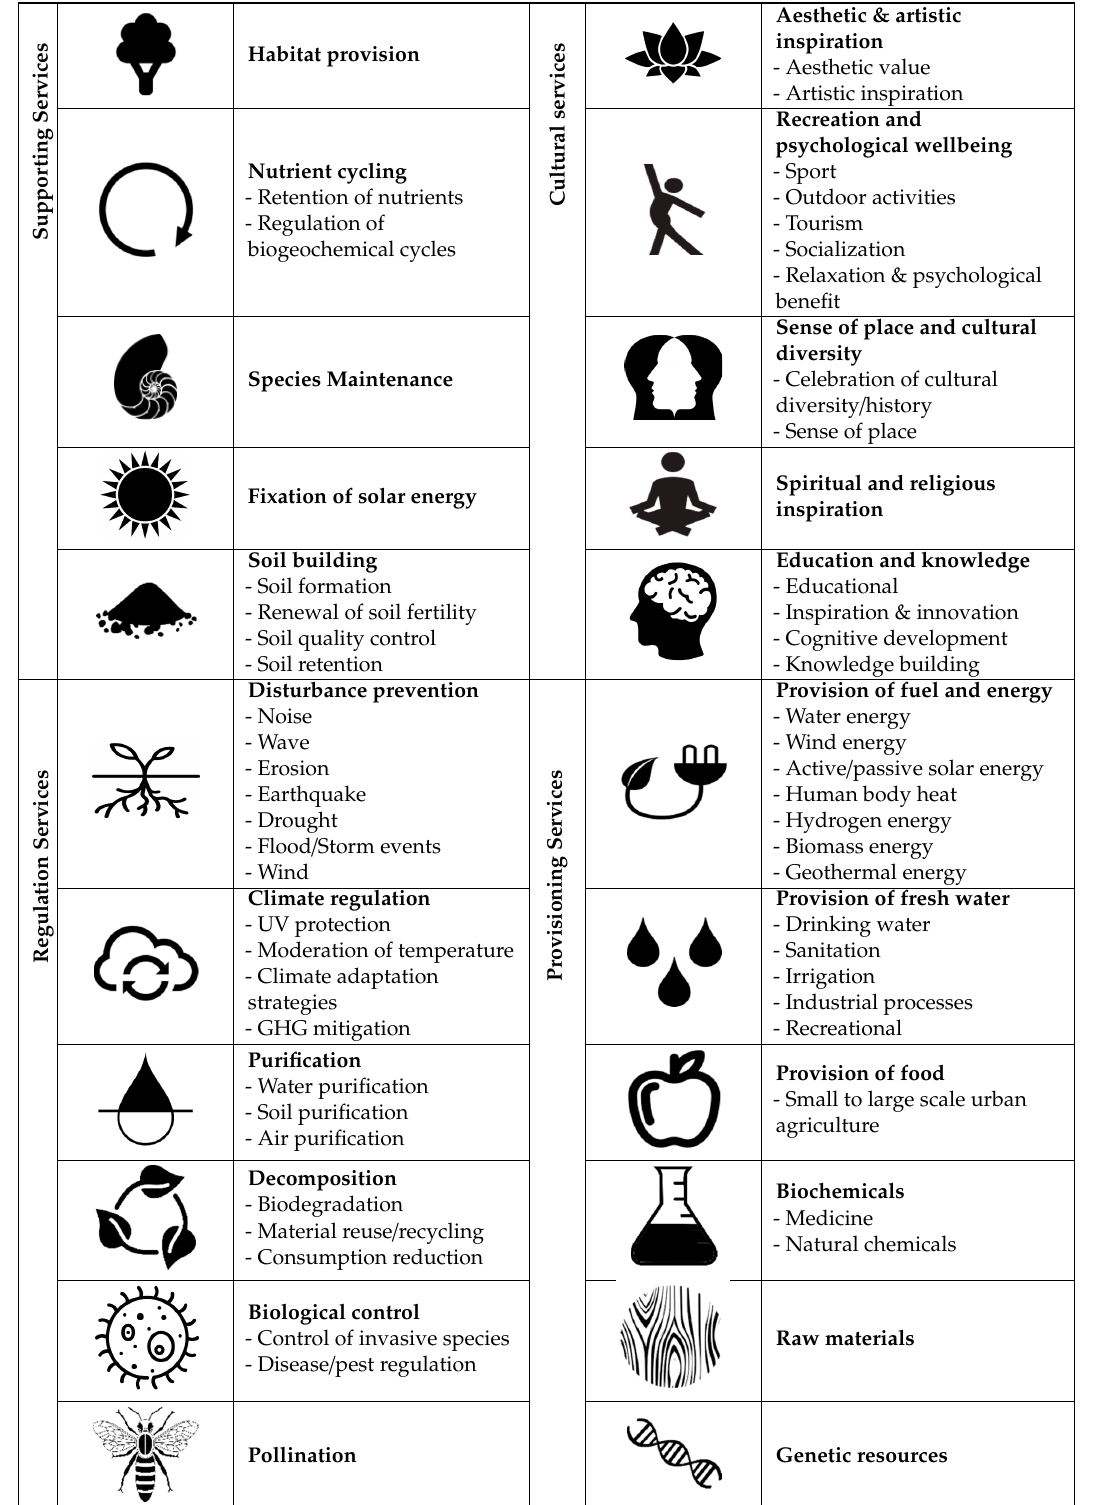
Table 1. Ecosystem Services.